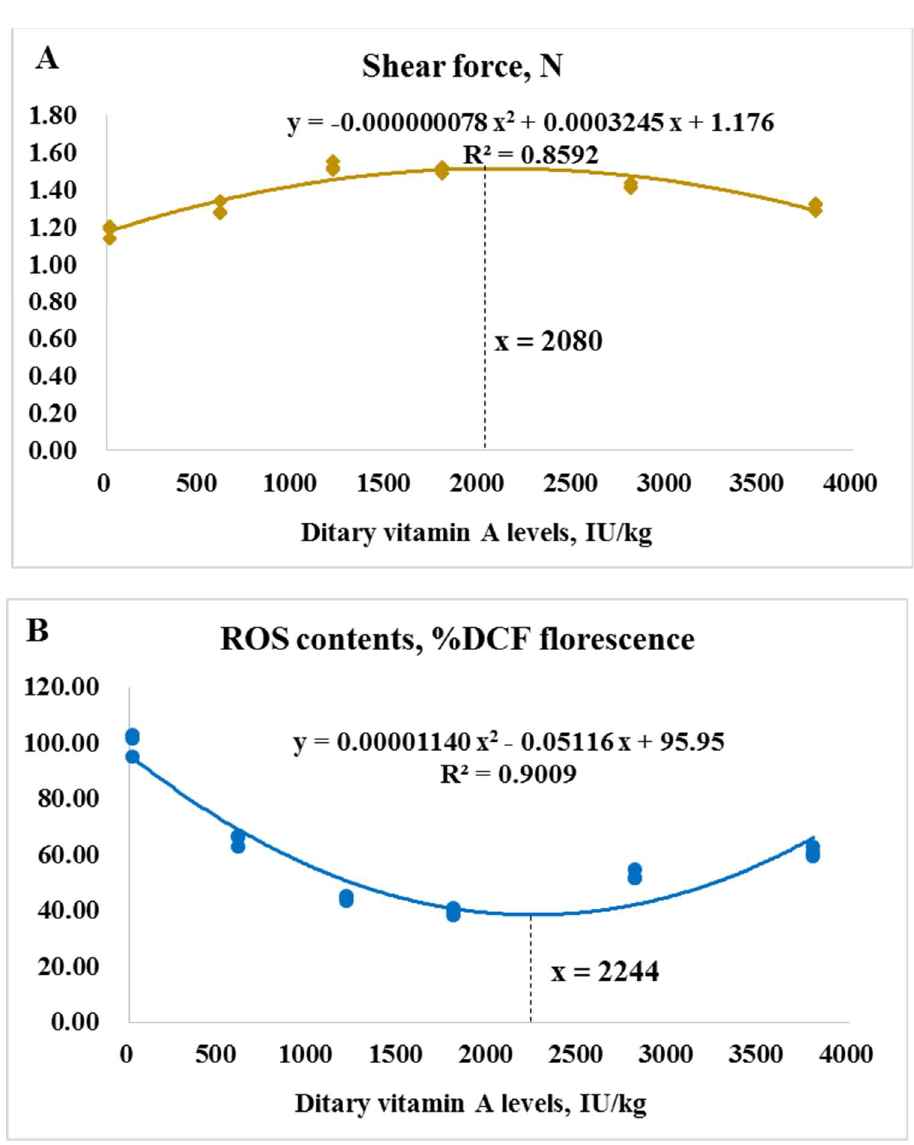
Figure 6. The dietary vitamin A requirements for on-growing grass carp based on muscle shear force ( A ) and contents of reactive oxygen species (ROS, ( B )).